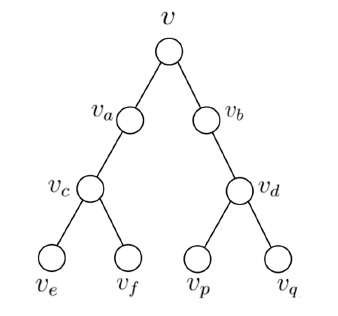
Figure 1. The tree T v